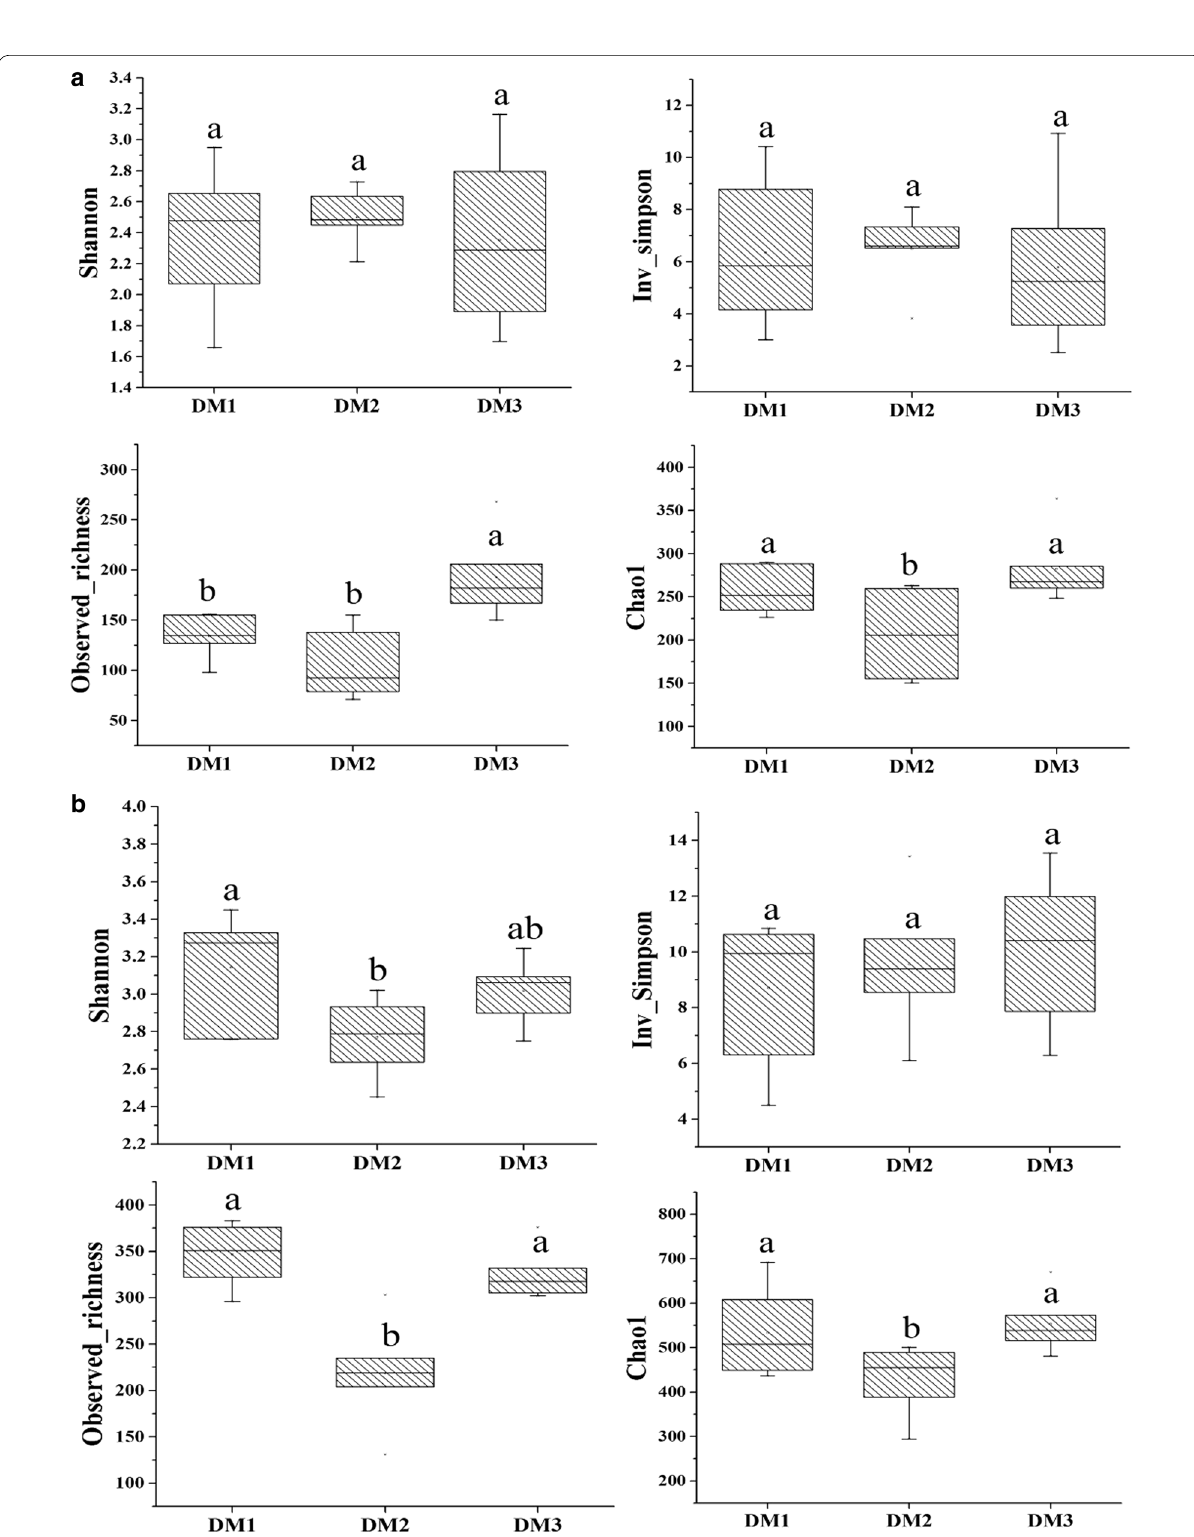
Fig. 1 Summary of α diversity indices under different disease severities. The α diversity indices including shannon, Inv_simpson indice, Observed_ richness and Chao1 in bacteria ( a ) and fungi ( b ). The data were analyzed based on a one‑way ANOVA followed by Duncan’s multiple range test at p < 0.05. DM1, DM2 and DM3 represent the three disease severities of angular leaf‑spot of cucumber, respectively. DM1 symptomatic‑mild, DM2 symptomatic‑moderate, DM3